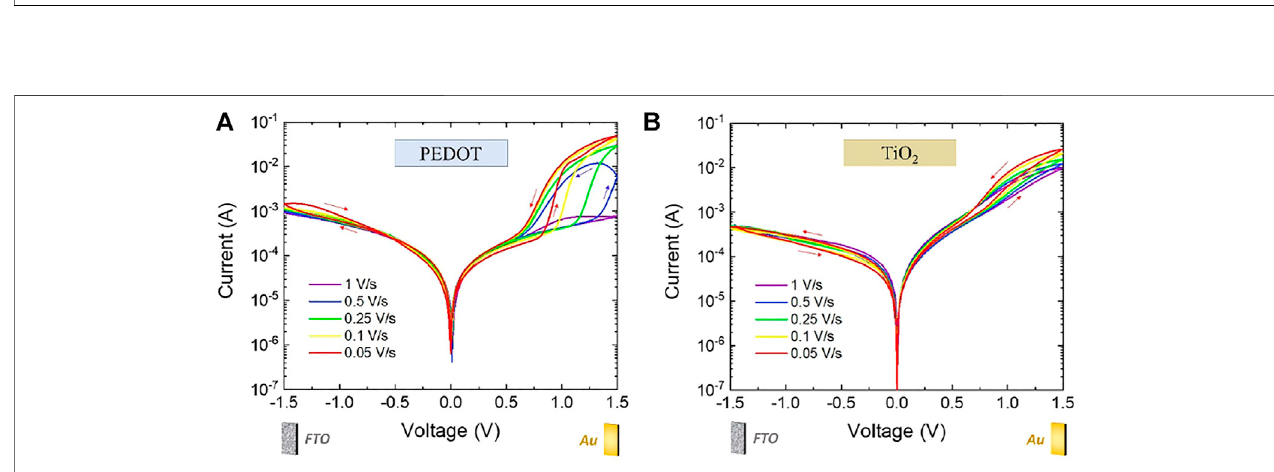
FIGURE 8 | (A) Current density − voltage characteristic measured at 50 mW/cm 2 blue light illumination for an FTO/c-TiO cell.Arrowsindicatesweepdirection. (B – C) Correspondingcomplexplaneplotrepresentationoftheimpedancespectraatvariousdcvoltages,measuredfrom1MHzto 0.1 Hz. Inset corresponds to higher dc voltages applied.